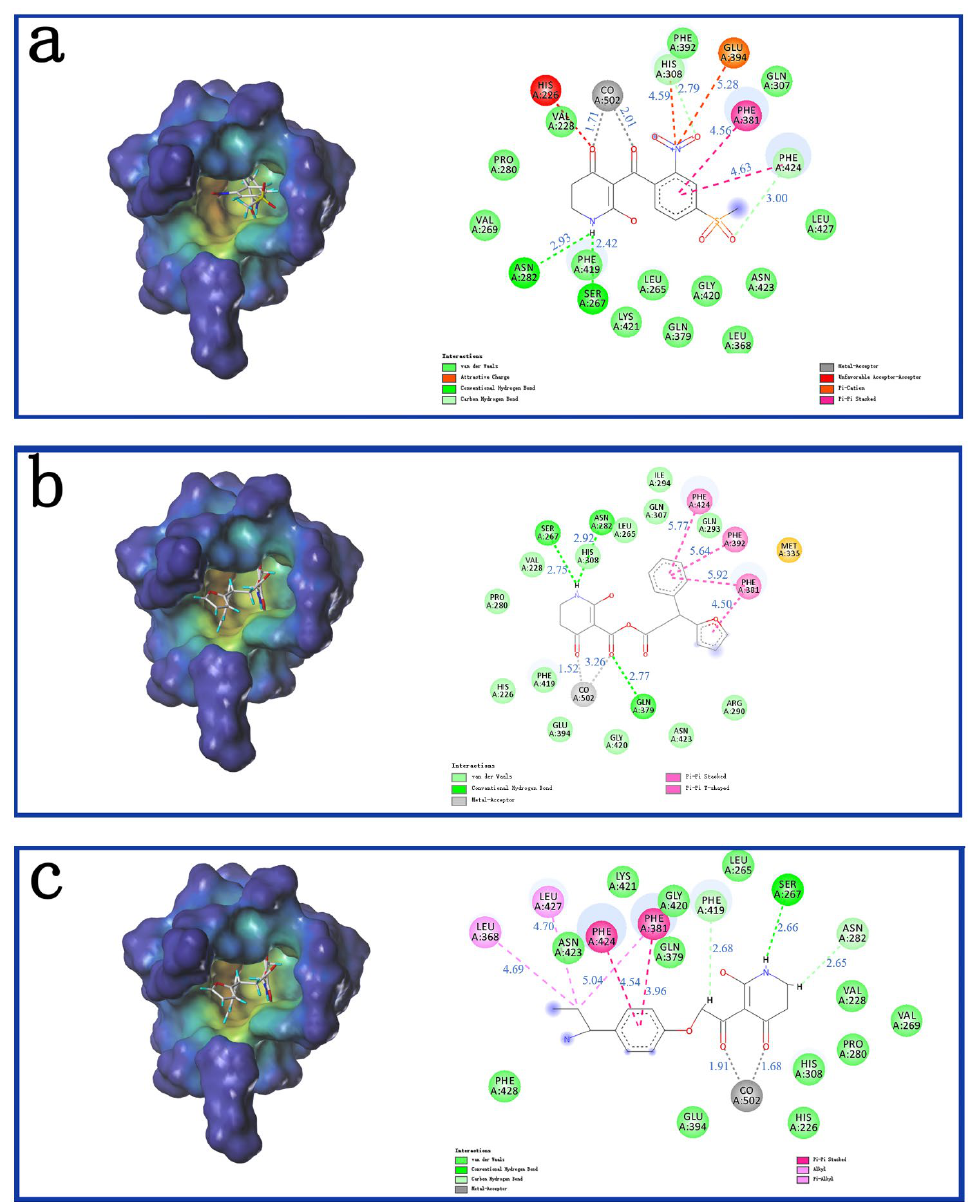
Figure 5. The receptor-ligand interaction of ZD-9 ( a ), Y12 ( b ) and Y14 ( c ) in the HPPD active site. Blue is the distance of the interaction (Å).